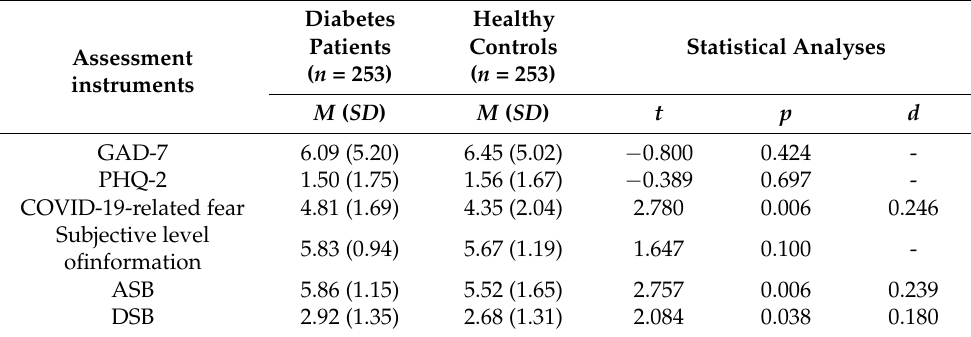
Table 2. Comparisons between patients with diabetes and healthy controls.